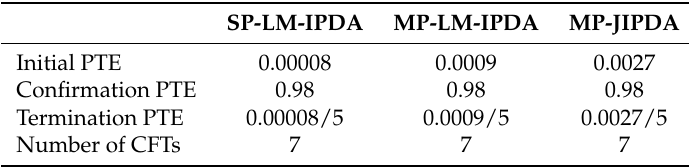
Table 4. Simulation parameters for different algorithms (Scenario